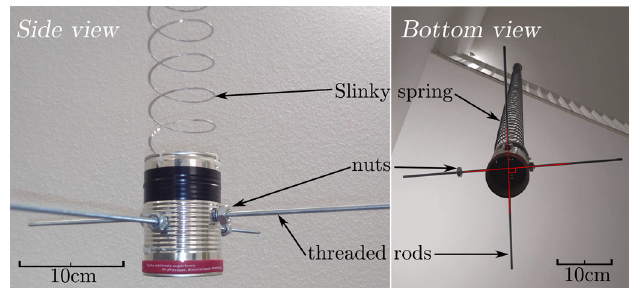
Fig. 2. Views of our hand-built prototype.